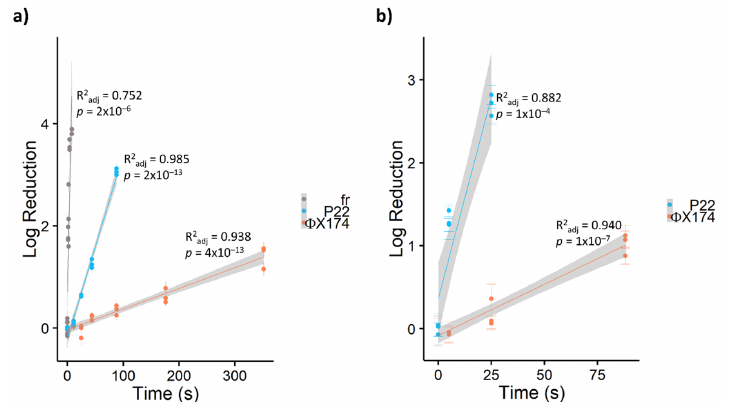
Figure 2. Log 10 reduction in bacteriophages via a) TMPyP- and b) PdT4-mediated blue LED photoinactivation. Bacteriophage fr is shown in a) as an example of extremely rapid inactivation of RNA bacteriophages. All points represent single experimental replicates (mean of 10 plaque counts). Error bars represent ± 1 standard deviation of measurement. Shaded regions represent 95% confidence intervals for the least-squares linear regressions.